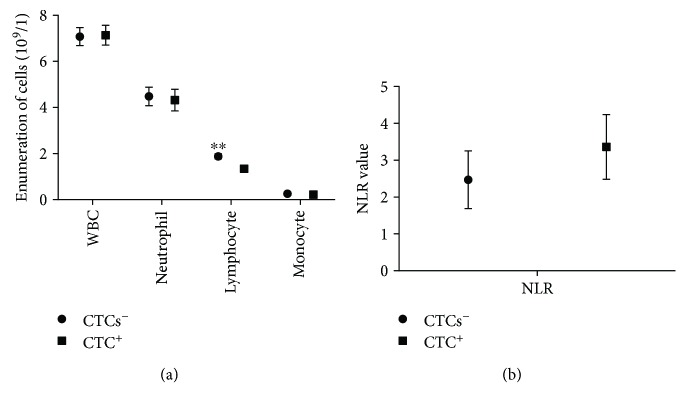
Immune cells in the peripheral blood of patients with colorectal cancer. (a) Difference in WBC, neutrophil, lymphocyte, and monocyte counts in CTC-positive and CTC-negative patients. (b) Neutrophil-to-lymphocyte ratio in CTC-positive and CTC-negative patients. ∗∗P < 0.01. WBC, white blood cell; CTC, circulating tumor cell.